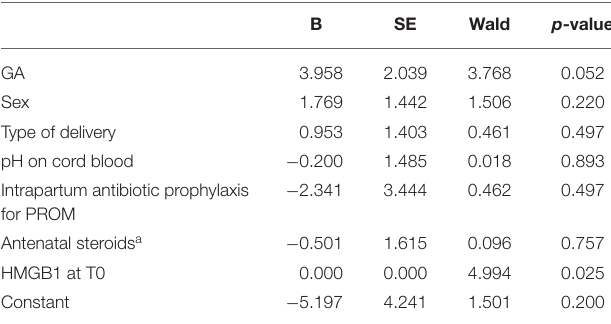
TABLE 2 | Binary regression analysis to evaluate influence of covariates on the risk of necrotizing enterocolitis developing. B SE Wald p